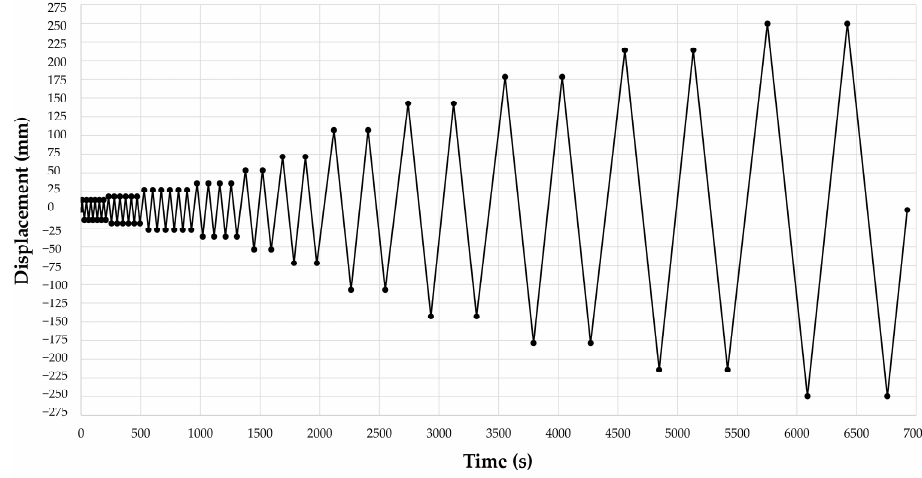
Figure 6. Displacement protocol. The abscissa is presented in units of time in s, obtained as the quotient between the displacement ∆ and the loading application speed v . In this case v = 1.49 mm/s.